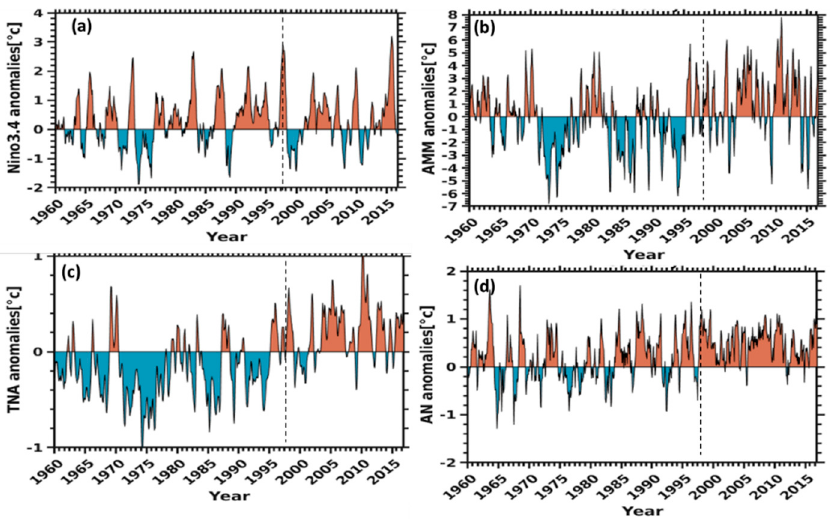
Figure 7. The standardized monthly Niño3.4 ( a ), AMM ( b ), TNA ( c ) and AN ( d ) time series for the period from 1960 to 2016. The vertical dashed lines indicate the year 1998.